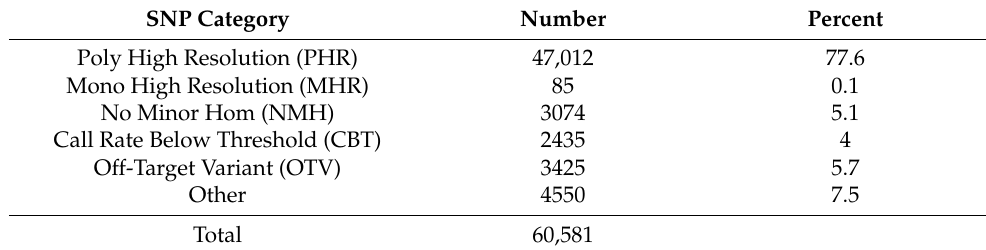
Table 2. Repartition of SNPs in the six categories.